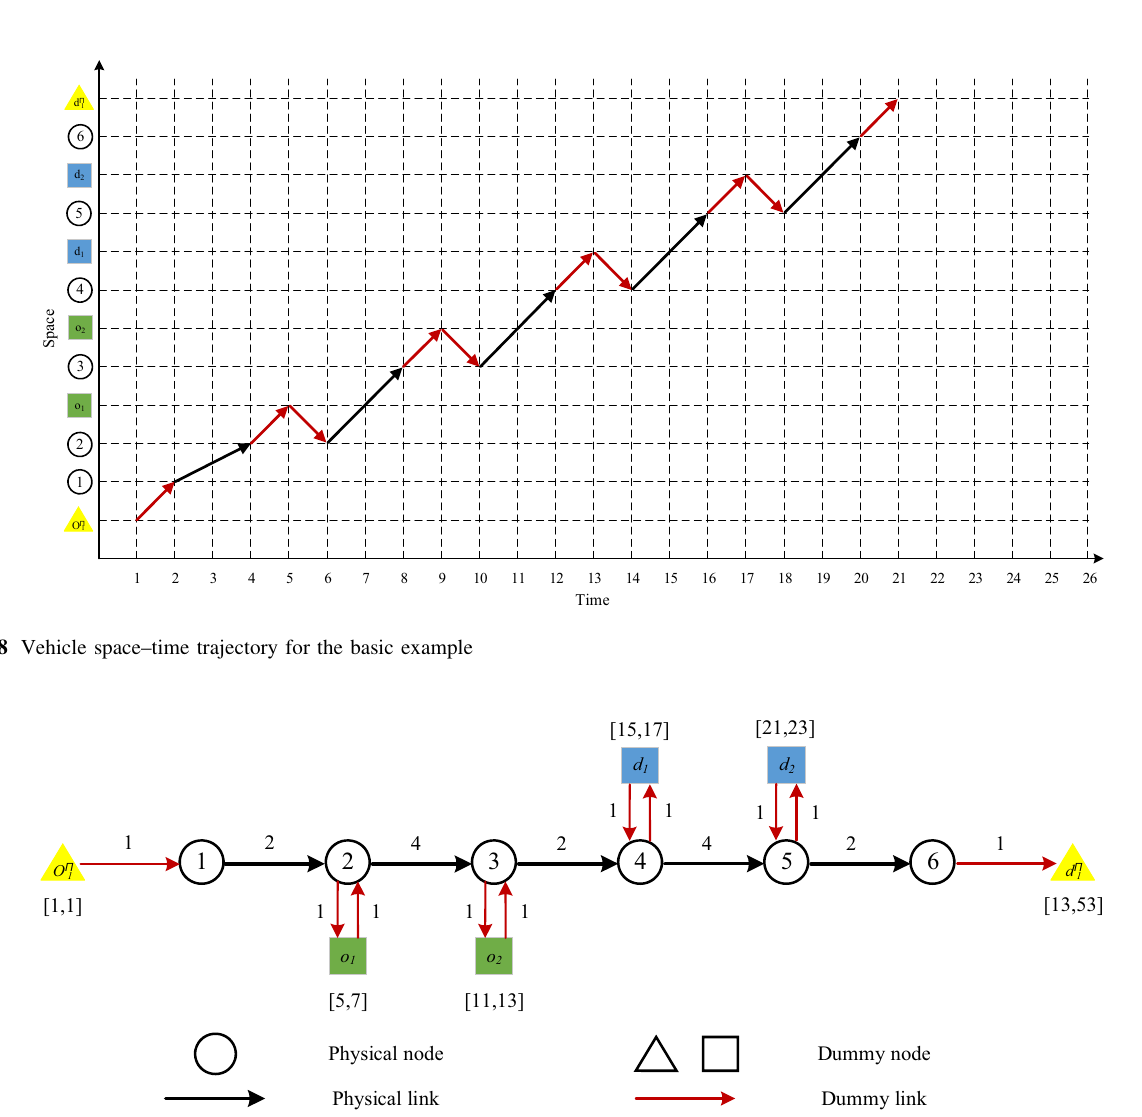
Fig. 9 Network layout and time-window settings for the example with extended link travel